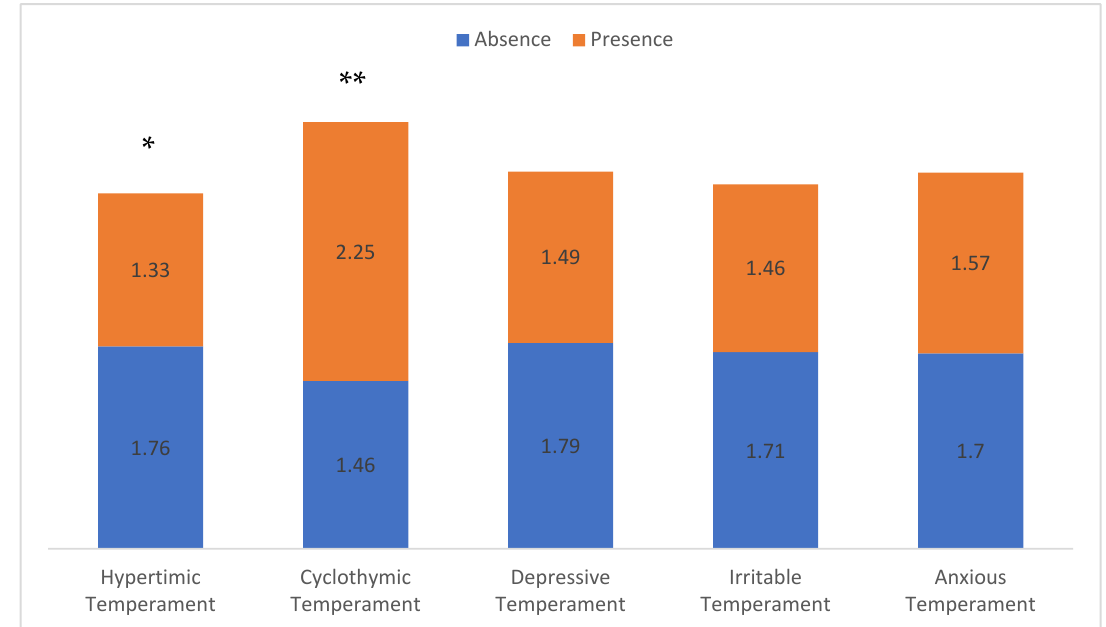
Figure 3. Number of suicide attempts according to dominant affective temperament. * p < 0.05, ** p < 0.001.